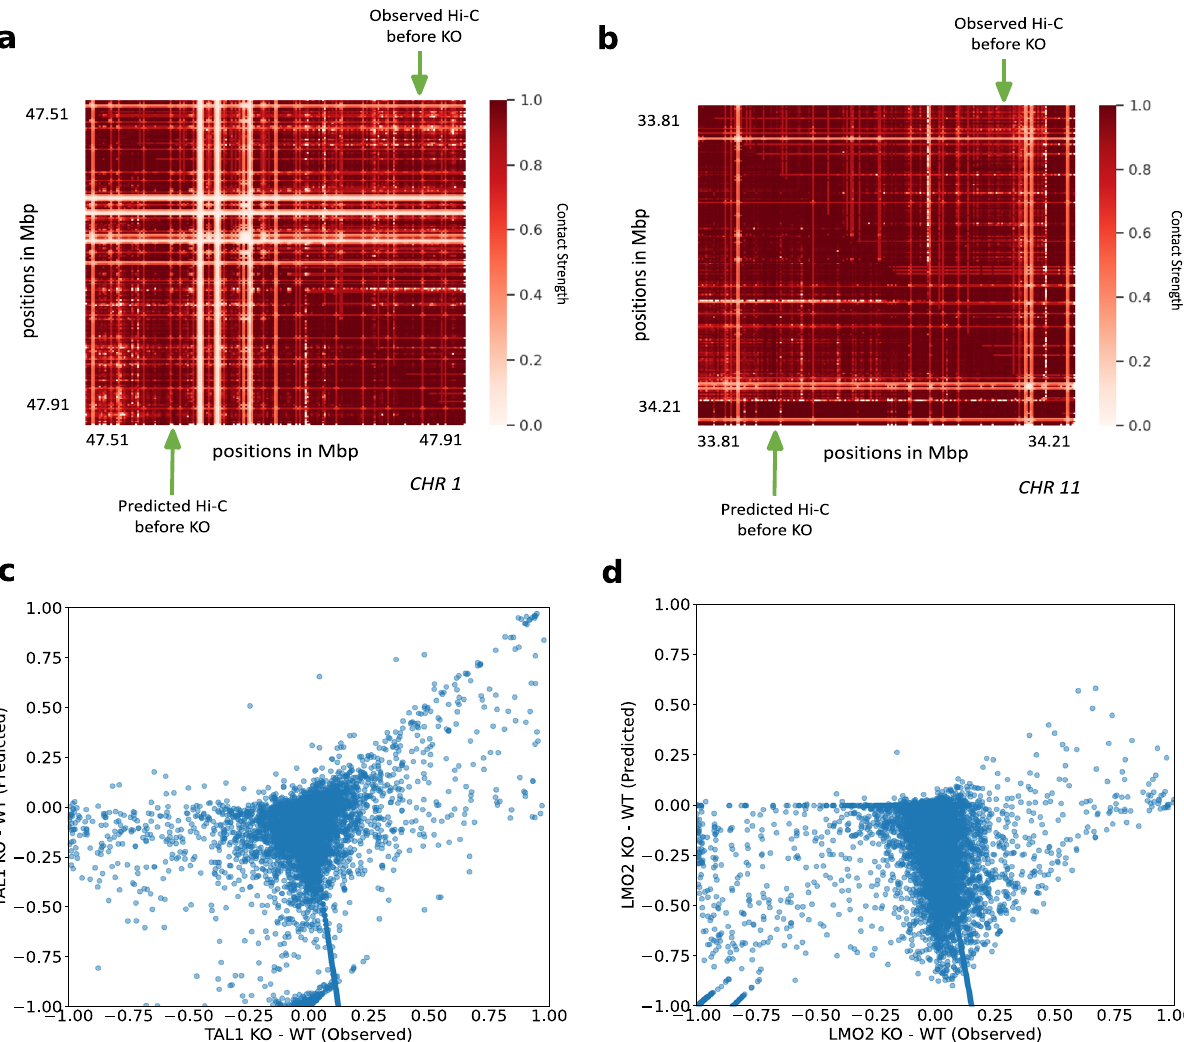
Fig. 9 In-silico anchor deletions at the TAL1 and LMO2 loci. a , c TAL1 anchor deletion on chromosome 1. a Observed Hi-C contacts before deletion (upper-triangle), and predicted Hi-C contacts before deletion (lower-triangle). c Scatter plot of differences in contacts after and before TAL1 deletion. The x -axis shows observed differences, and the y -axis shows predicted differences. b , d LMO2 anchor deletion on chromosome 11. b Observed Hi-C contacts before deletion (upper-triangle), and predicted Hi-C contacts before deletion (lower-triangle). d Scatter plot of differences in contacts after and before LMO2 deletion. The x -axis shows observed differences, and the y -axis shows predicted differences, KO knockout, WT